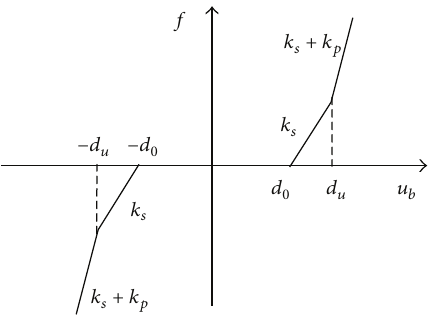
Figure 3: Force-displacement curve of protective systems.